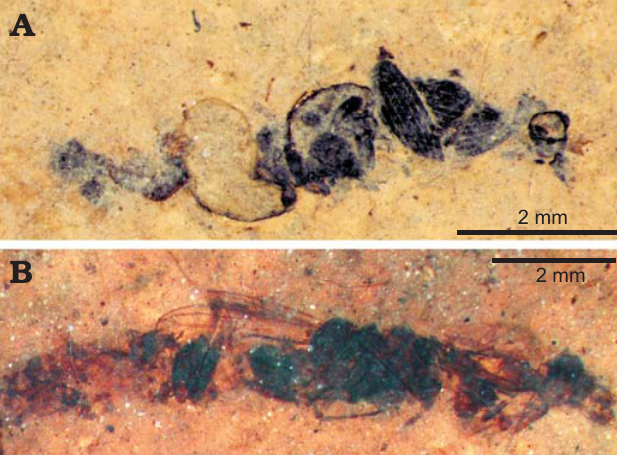
Fig. 10. Fossil coprolites in oil shale from the Coal Creek member of the Kishenehn Formation, Eocene, Montana, USA. A . USNM 593436, coprolite composed entirely of beetle elytra. B . USNM 593437, coprolite that contains a heterogeneous accumulation of insect parts including dipteran